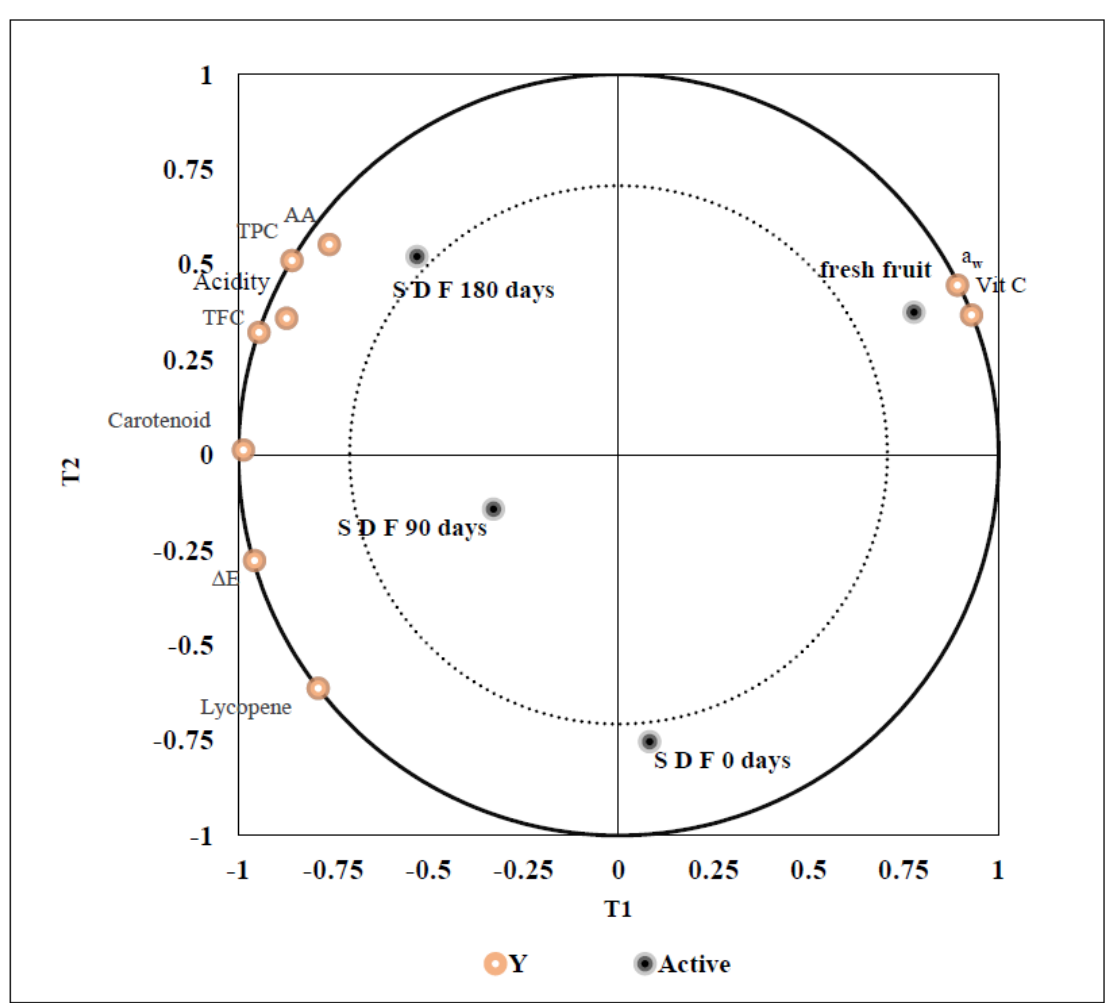
Figure 2. Partial least squares regression analysis (PLS) of color ( ∆ E), a w , total acidity, vitamin C content, total carotenoids, lycopene content, TPC, TFC, and AA of fresh fruit, solar-dried fruit (S D F 0 days), solar-dried fruit stored for 90 days (S D F 90 days), and 180 days (S D F 180